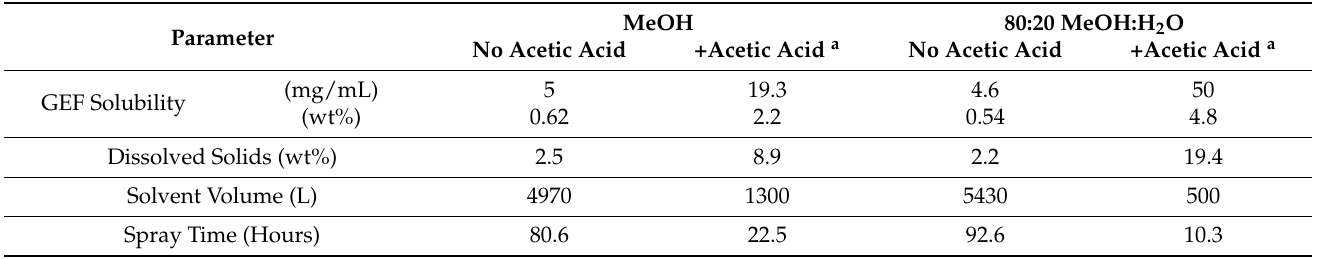
Table 3. Throughput estimate for 100 kg of 25% GEF SDD assuming maximum API solubility of GEF shown in Figure 2, assuming a solution feed rate of 50